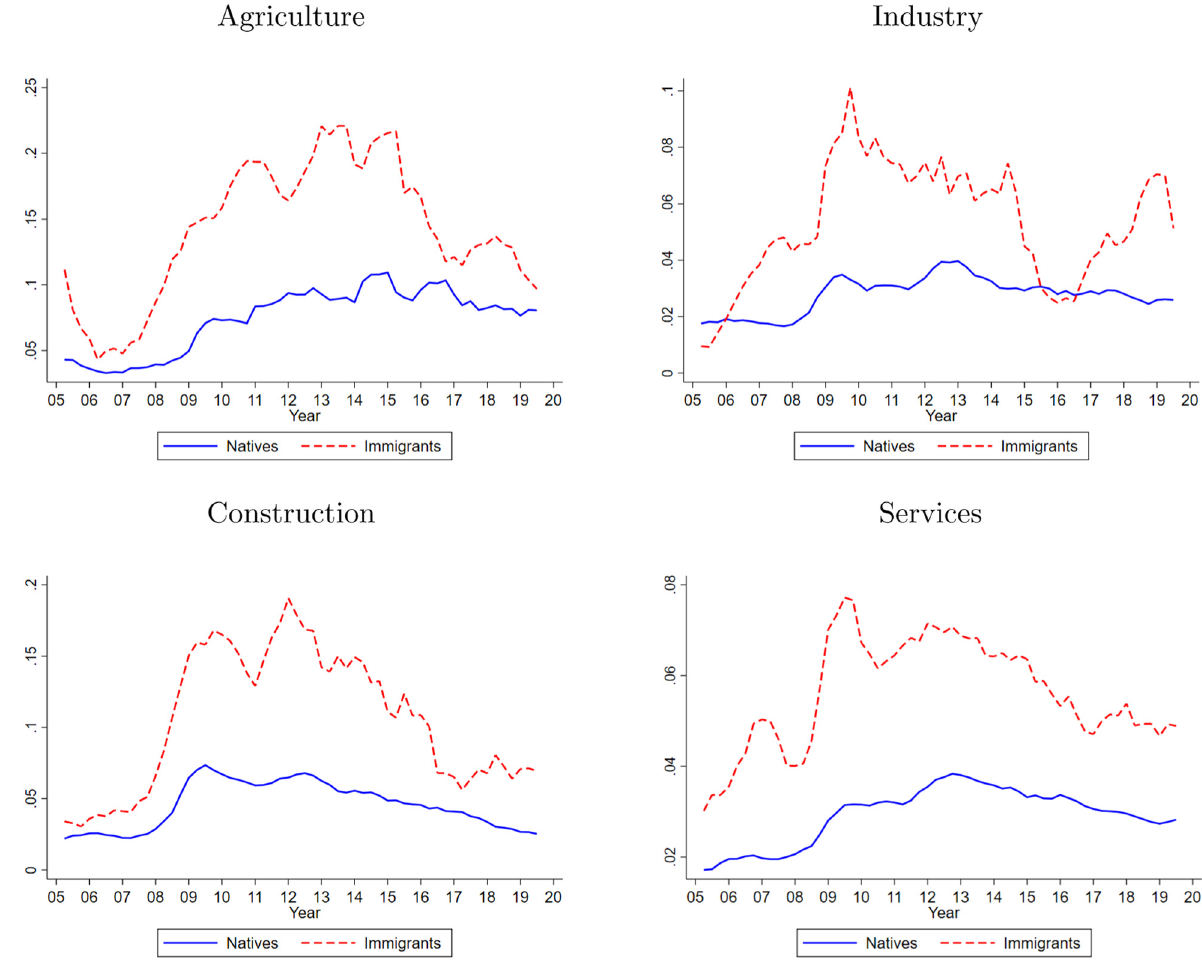
Figure A6: Job - separation rate by nationality and sector. Note: The transitions are seasonally adjusted using a 4 - quarters moving average, constructed from the Spanish Labour Force Survey -